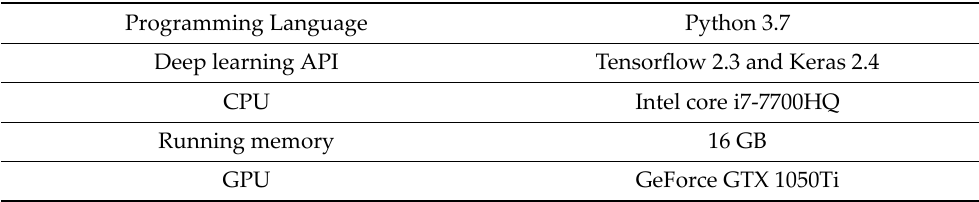
Table 4. The configuration of experiment platform.